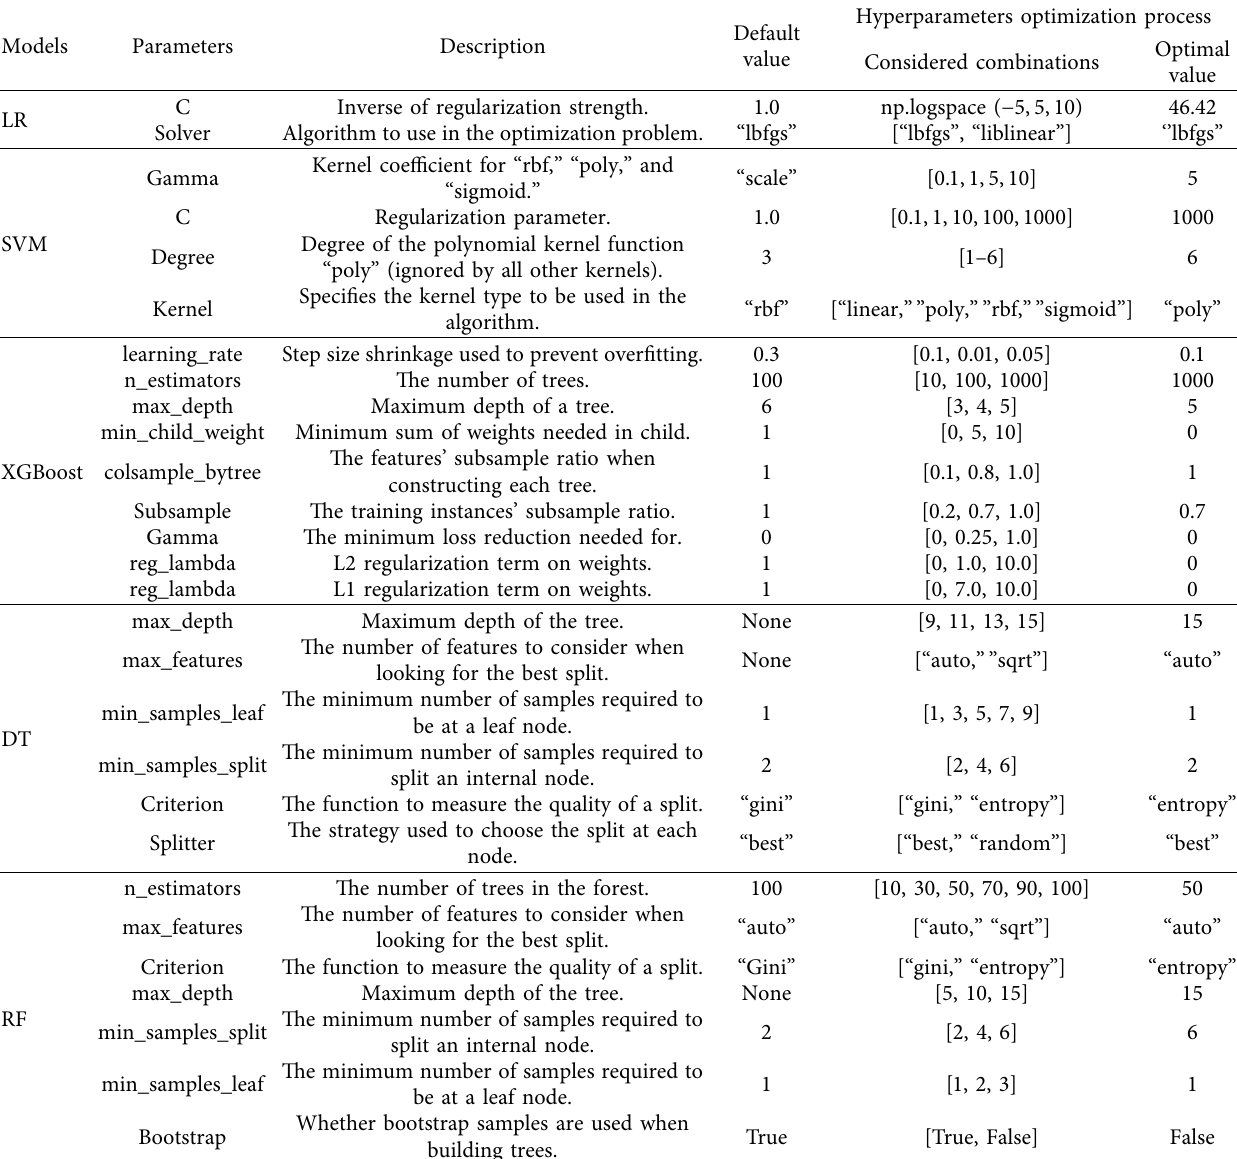
Table 2: Hyperparameters optimization for ML classifiers.